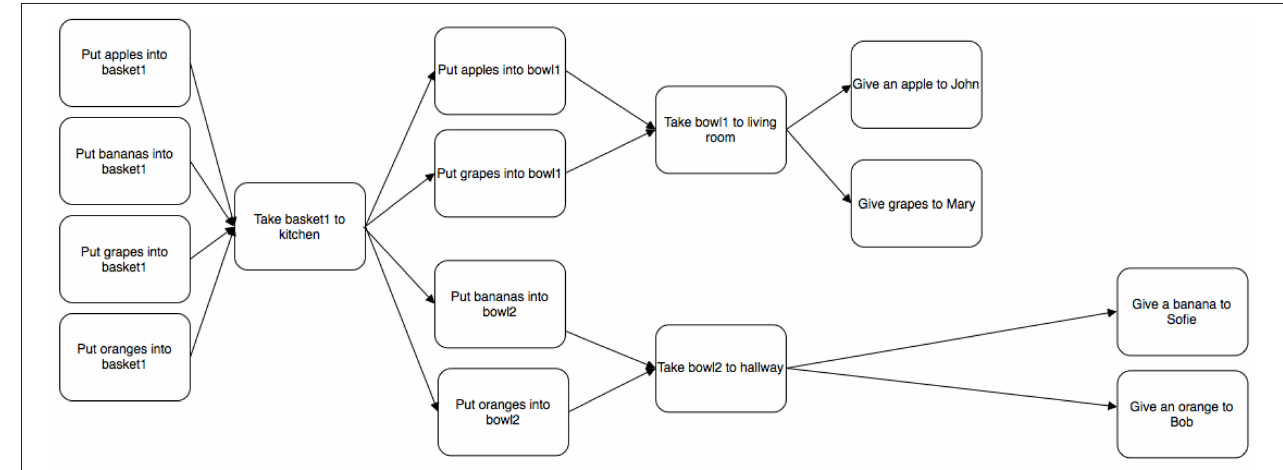
FIGURE 1 | Example of a simple plan